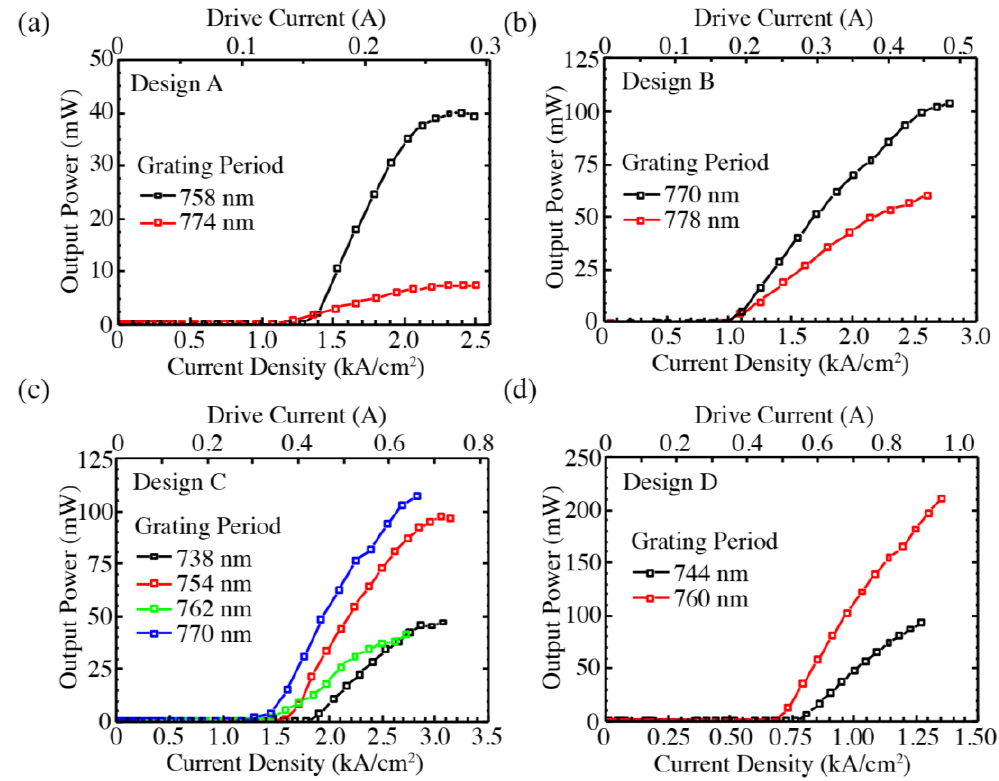
Figure 4. Pulsed output power vs. injection current density at 20 °C for DFB QCLs with the four different designs and various grating pitches. Light is collected from a polished hybrid Si/III-V facet.